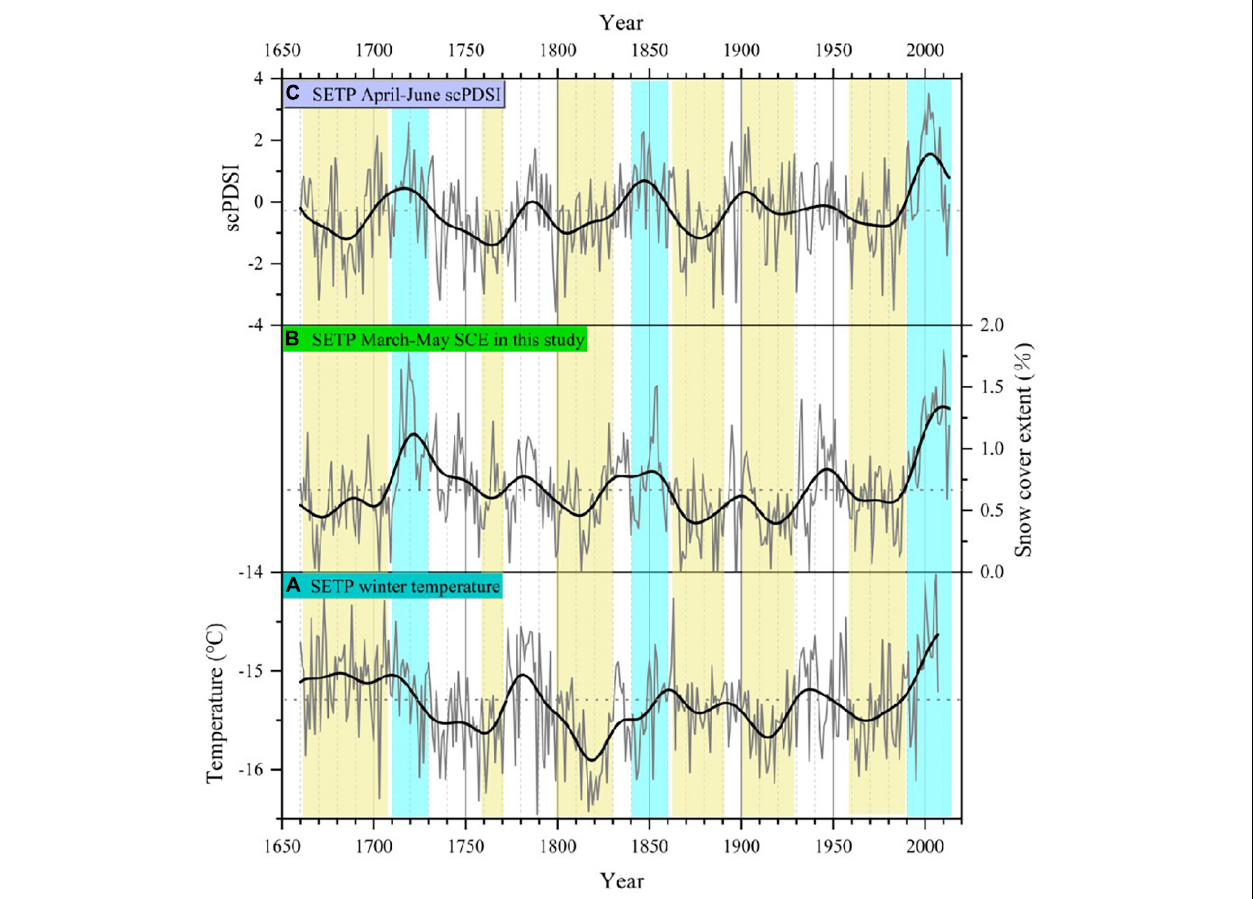
FIGURE 9 | Comparisons of the (A) reconstructed April–June scPDSI on SETP (1660–2013 CE) (Li J. B. et al., 2017), (B) reconstructed SCE 3 − 5 from this study (1660–2013 CE), and (C) reconstructed winter temperature on the SETP (1660–2010 CE) (Huang et al., 2019). The heavy black curve corresponds to the 11-year average smoothing series. Shade bars indicate the common fluctuation